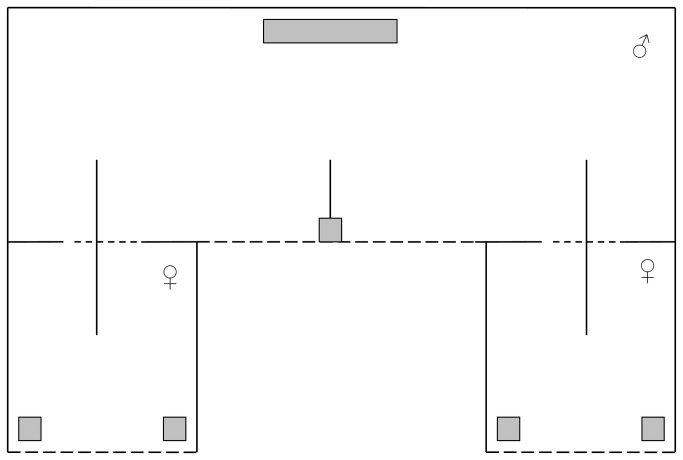
Diagram of the choice test apparatus used in the experiment.The dark gray lines represent the perches. The light gray squares represent the food and water containers. Dotted lines represent grated cage walls.